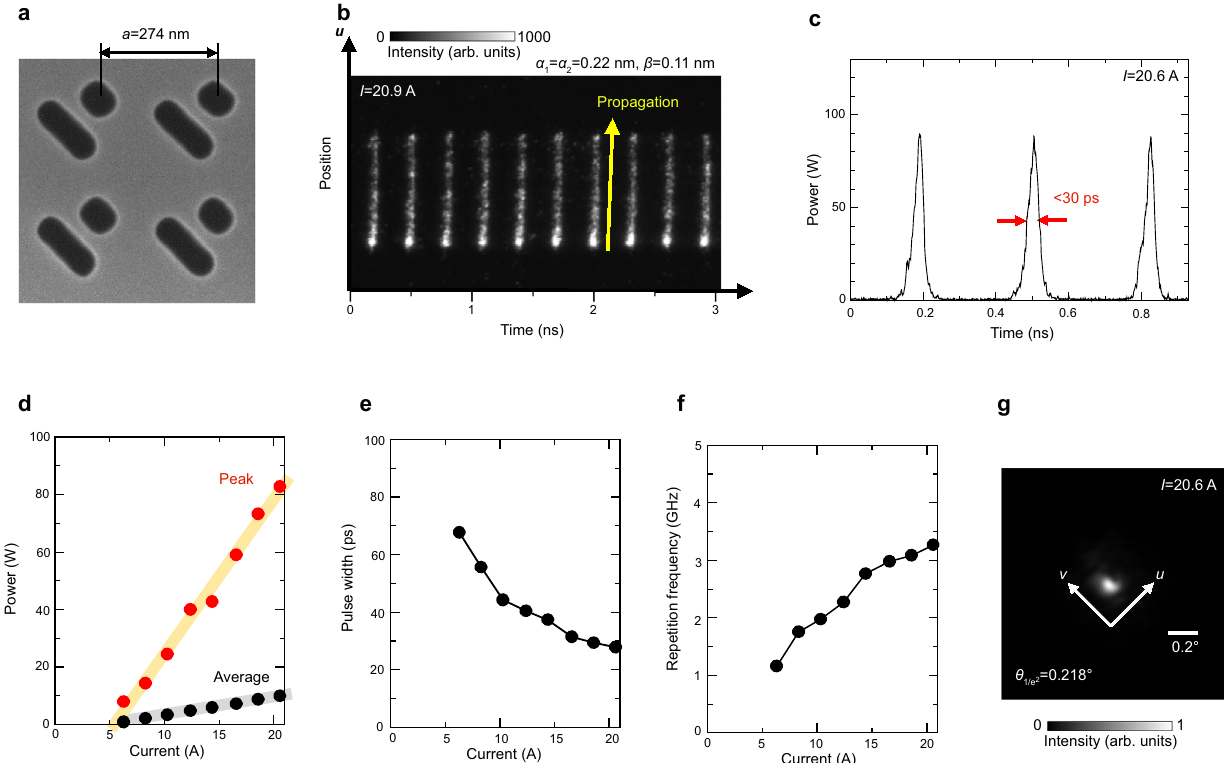
Fig. 3 | Experimental demonstration of short-pulse generation in self-evolving photonic crystals. a Scanning electron microscope image of a fabricated double- lattice photonic crystal. b Streak camera image of the fabricated device at an injectioncurrentof20.9A. c Temporalchangeoftheoutputpowerofthedeviceat an injection current of 20.6A. d Peak power and average power of the device as a